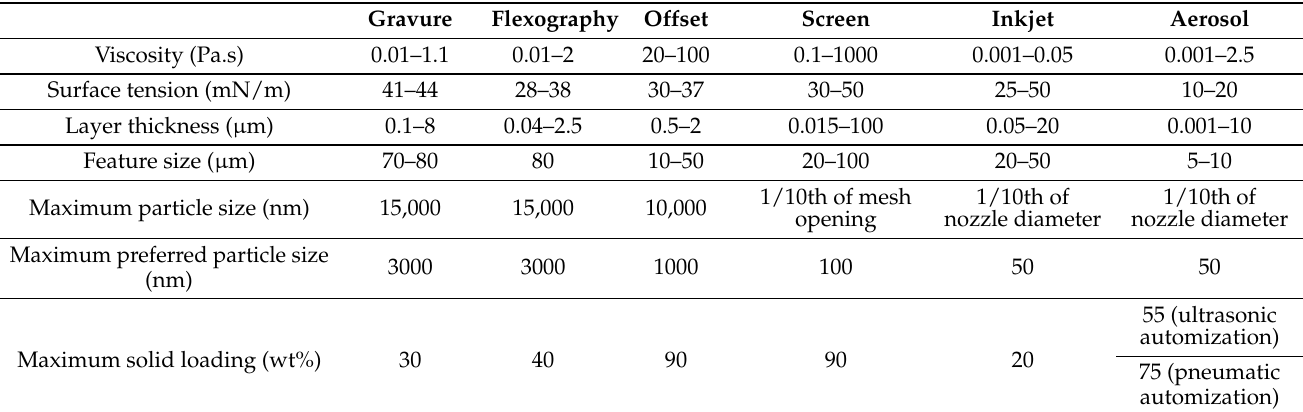
Table 4. Ink characteristics for different printing methods [156,166,167]. Gravure Flexography Offset Screen